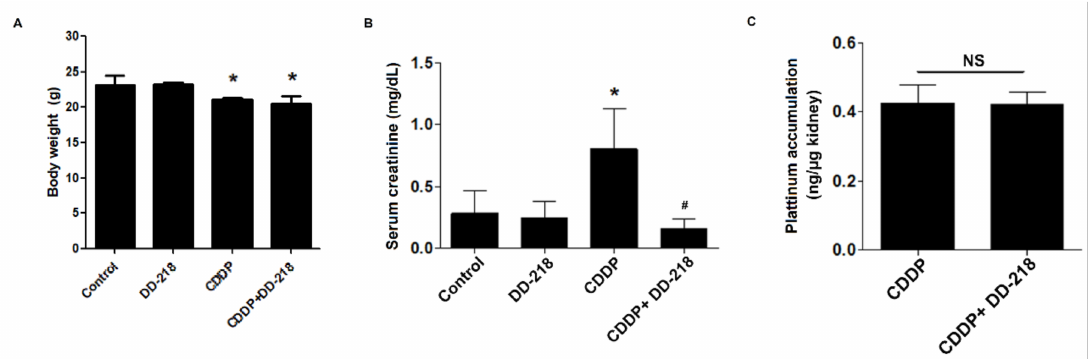
Figure 7. The protective effect of DD-218 on CDDP-induced nephrotoxicity. C57BL/6 mice were treated with: saline for 3 days (control) n = 5; 50 mg/kg/day of DD-218 for 6 days, n = 5; a single dose 20 mg/kg of CDDP n = 6; 50 mg/kg/day of DD-218 for 3 days followed by co-treatment of a single dose of 20 mg/kg of CDDP and 50 mg/kg/day of DD-218 for 3 days, n = 7. ( A ) Body weight of mice after treatments. ( B ) Serum creatinine. ( C ) Renal platinum accumulation. Values are expressed as means ± SD: * p < 0.05 compared to control; NS indicates non-significance compared to control; # p < 0.05 compared to CDDP